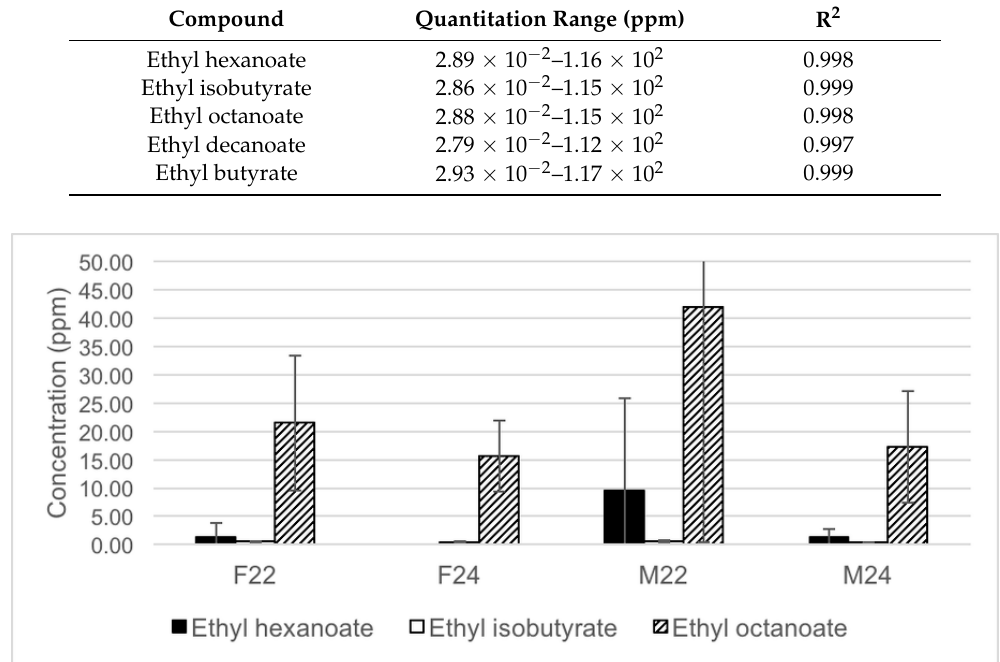
Figure 8. Concentrations of target analytes in headspace of Marquette and Frontenac wines made from berries harvested at 22° and 24° Brix. A five-point external calibration was performed using standards spiked into model wine. Data represent the mean of replicate analysis ( n = 3) of each wine produced. F22 represents Frontenac wine produced from berries harvested at 22° Brix, F24 represents Frontenac wine produced from berries harvested at 24° Brix, etc.